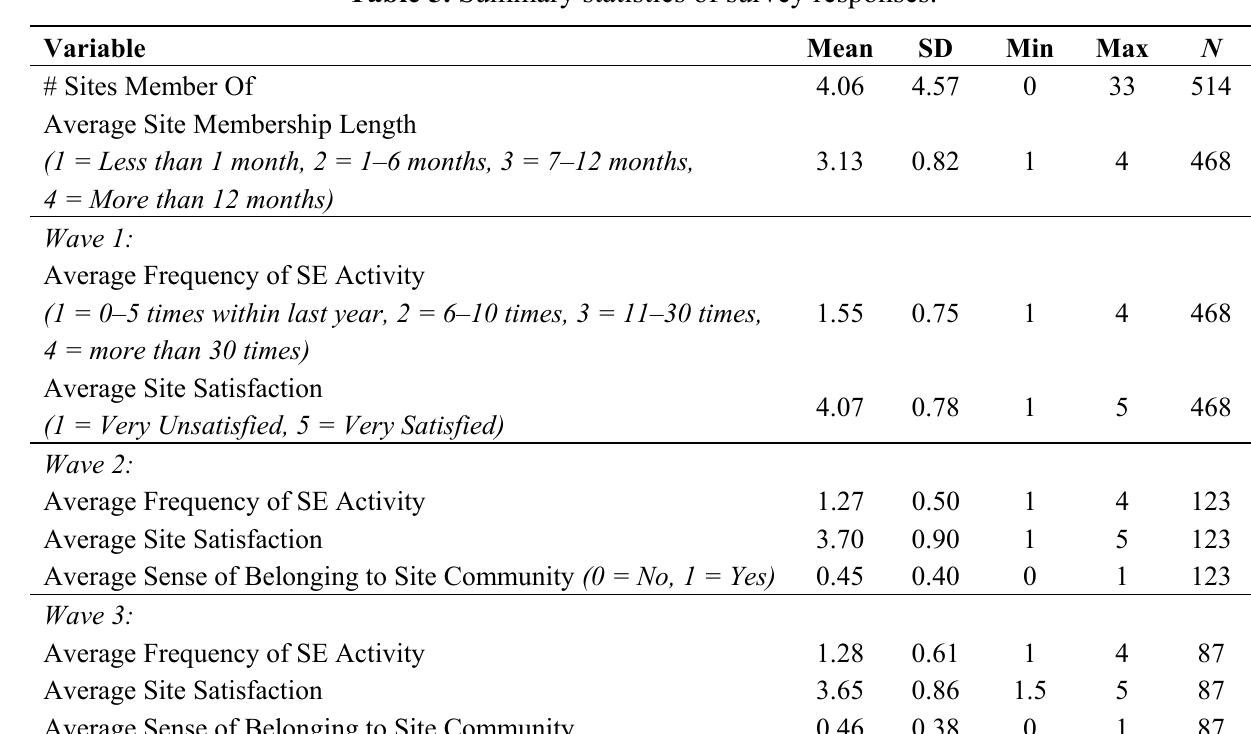
Table 5. Summary statistics of survey